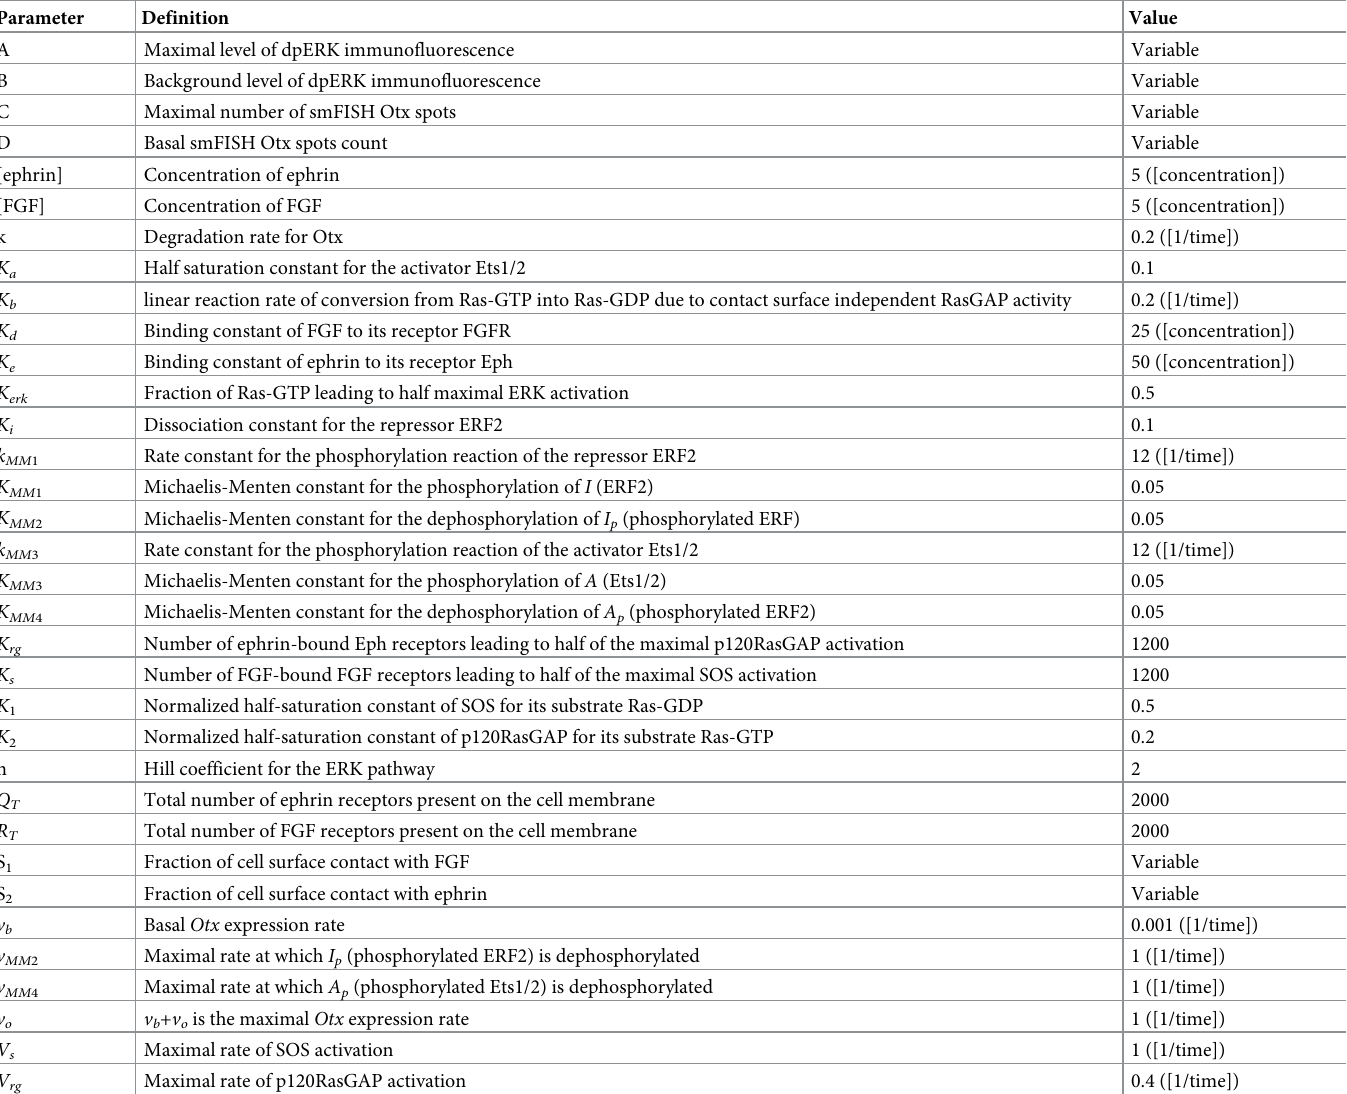
Table 1. Default values of parameters. All the units reported in the table are arbitrary. Parameter values were obtained by manual fitting to get best agreement with experimental observations. The values of the parameters of the two modules of the model were fitted separately. For the first module (model of ERK activity), fitting was performed manually to reproduce the experimental data obtained in ephrin inhibited embryos (S1B and S1C Fig), to set the values of the following parameters: V s , K 1 , K s , K b , K erk , K d , [FGF]. Fitting was then performed on the experimental data obtained in wild type embryos (Fig 2A and 2B) to set the values of the remaining parameters: V rg , K 2 , K rg , K e , [ephrin]. Finally, to fix the values of the parameters in the model of Otx expression (k MM3 , K MM3 , v MM4 , K MM4 , k MM1 , K MM1 , v MM2 , K MM2 , v b , v o , K a , K i , k) fit- ting was done on Fig